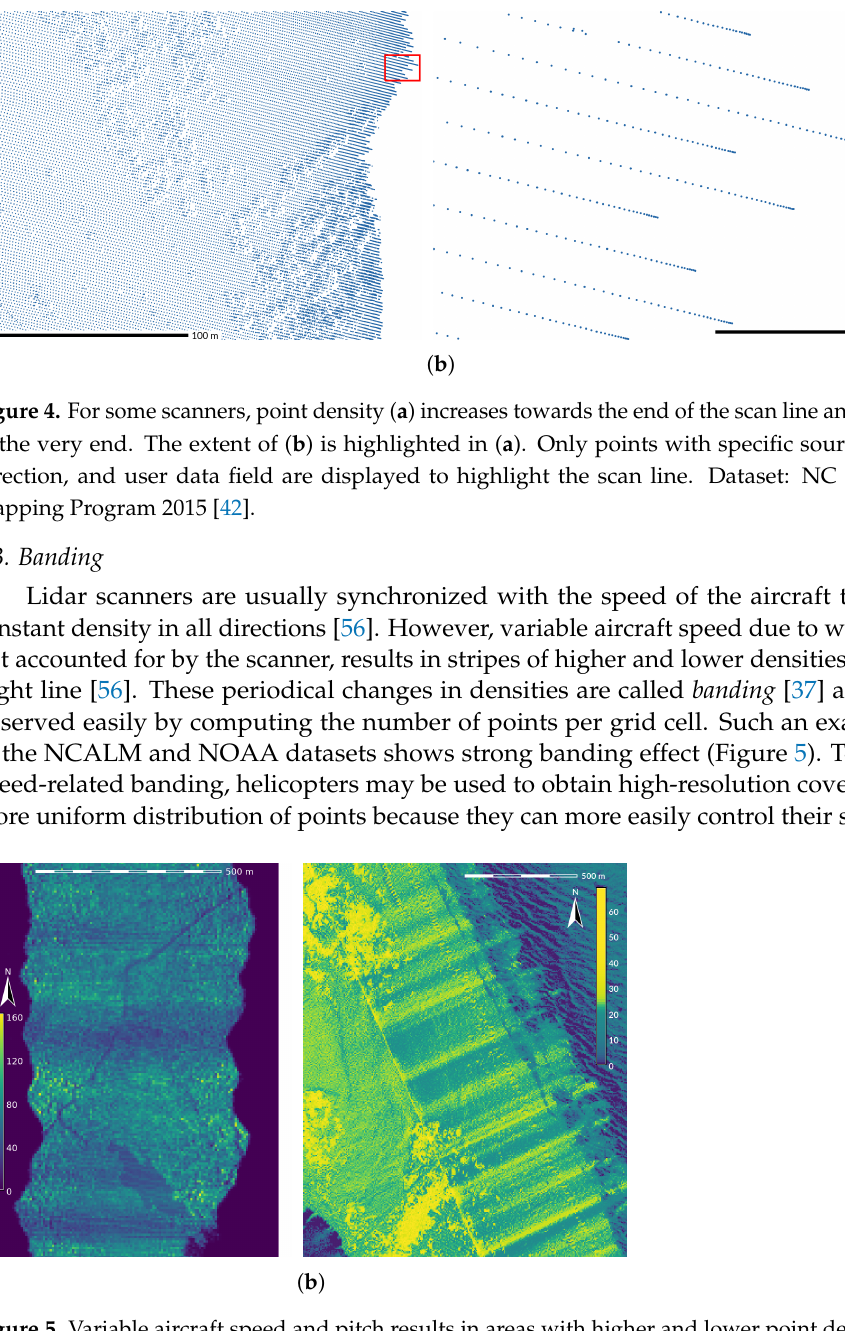
Figure 5. Variable aircraft speed and pitch results in areas with higher and lower point density along the flight line (here approximately north-south direction). Point density is expressed as the number of points per grid cell at 6 m resolution ( a) and 5 m resolution ( b ). Darker areas indicate lower point density while lighter areas indicate high density. Datasets: NCALM 2009 [44] ( a ) and NOAA 2008 [47] ( b